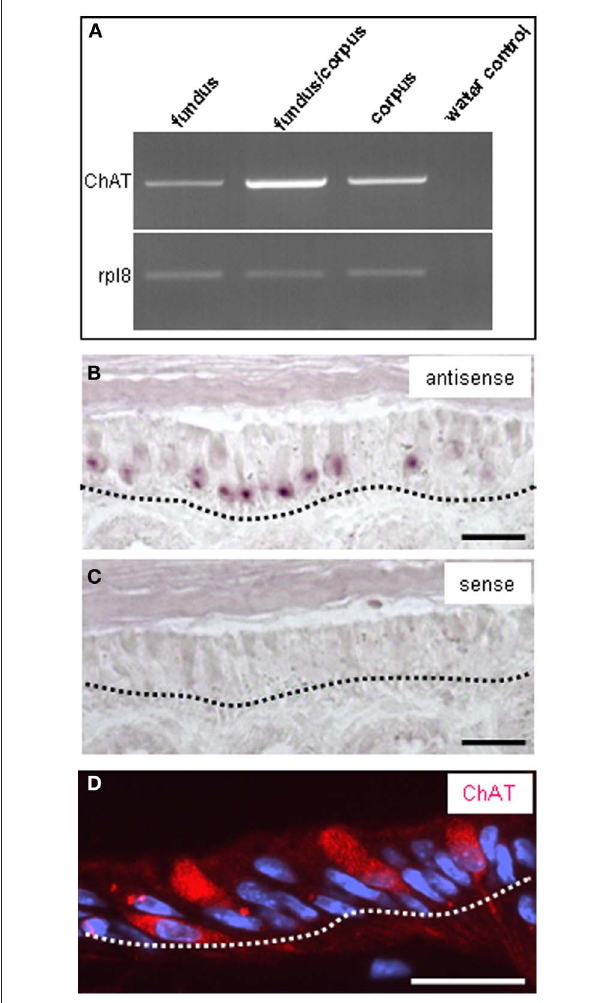
FIGURE 7 | Expression of choline acetyltransferase (ChAT) and the ribosomal protein l8 (rpl8) in the gastric mucosa. (A) Semi quantitative RT-PCR approaches for choline acetyltransferase (1093bp) or rpl8 (204bp) with normalized cDNA from gastric tissue of fundus, fundus/corpus transition zone, and corpus resulted in amplicons of the expected size for each region; the strongest band was obtained for the fundus/corpus transition zone. (B) In situ hybridization experiments with an antisense riboprobe for ChAT reveals the expression pattern of the enzyme. Cluster of mRNA-expressing cells can be visualized in the most apical corpus mucosa (depicted by black dotted line ) directly underneath the “limiting ridge.” (C) Control experiments with the corresponding sense riboprobe for ChAT show no staining. (D) Immunostaining with an antibody against choline acetyltransferase labels numerous cells in the most apical mucosa cell layer (denoted by the white dotted line ) underneath the “limiting ridge,” reminiscent of the position of ChAT mRNA-expressing cells seen in in situ hybridization experiments in (B) . Sections were counterstained with DAPI ( blue ). Scale bars: (B–D) = 20 μ m.